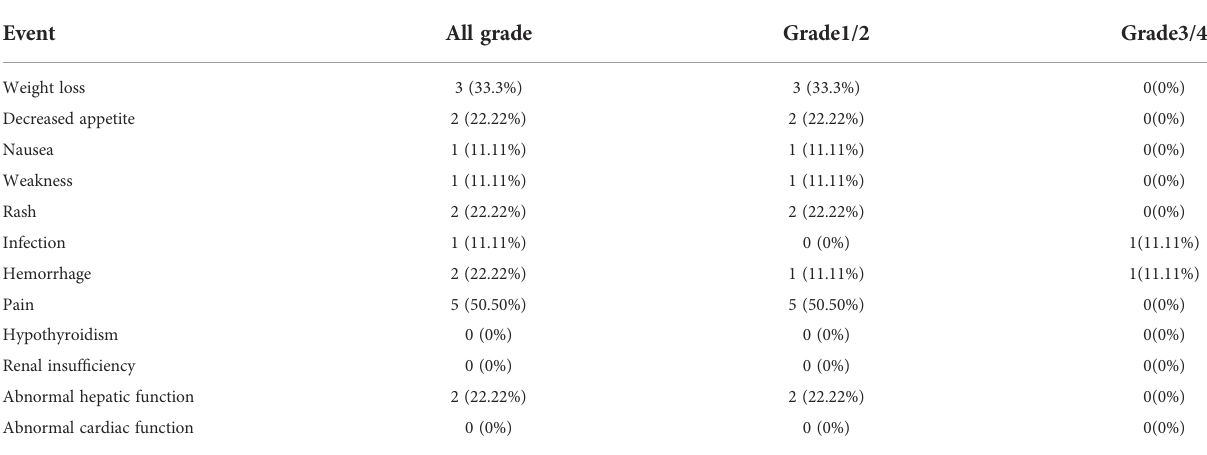
TABLE 3 Treatment-related adverse